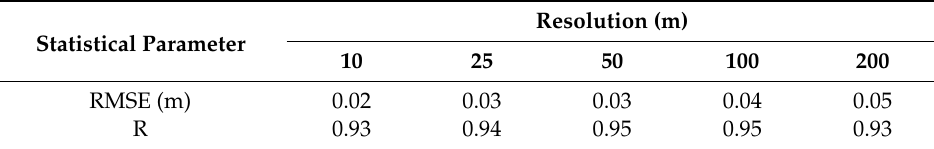
Figure 9. Inundation estimated by ( a ) MIKE 21 and ( b ) the CA simulated inundation, and ( c ) their difference (MIKE 21-CA) at 480 min.